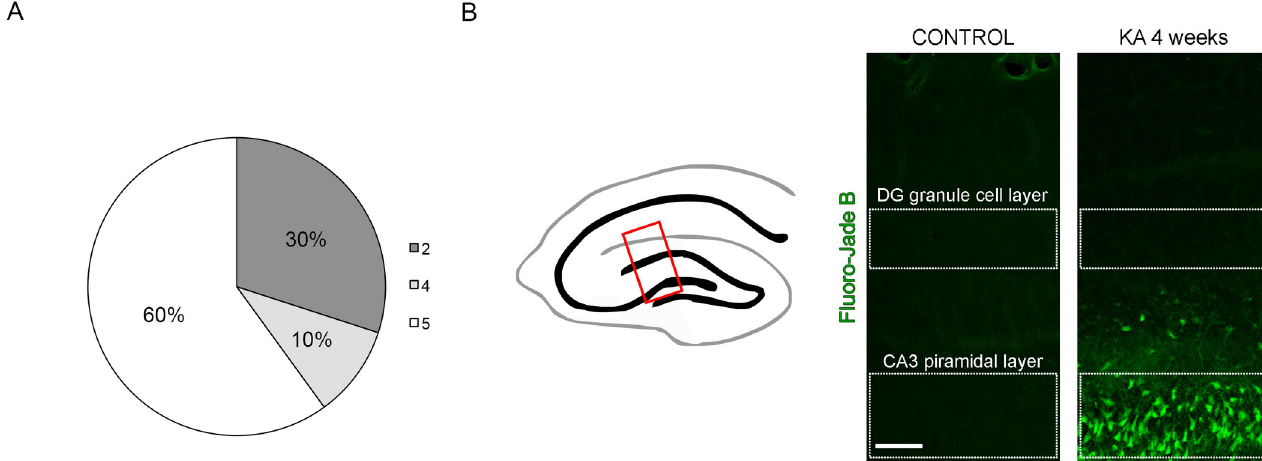
Fig 1. Kainate induced seizures and neuronal damage. A) Percentage of animals showing seizures after kainite administration. The intensity of seizure was scored according to the 6-grade modified Racine’s scale (0-lack of seizures—5- fully developed tonic-clonic seizures with loss of posture). B) Fluoro-jade B staining (depicted in green) showing neuronal damage in the CA3 region, but not the DG region of the hippocampus of kainite treated animals. Scale Bar: 100 μ m.